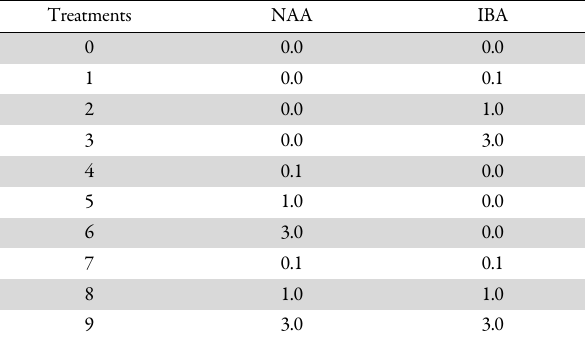
Table 1. Different combinations of NAA and IBA (mg l -1 ) used for rooting